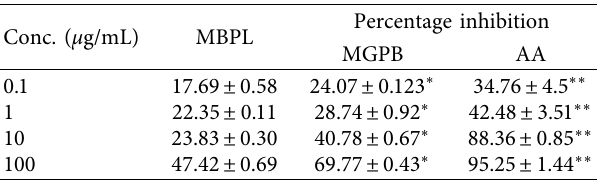
Figure 1: Calibration curve of gallic acid standard for total phenolic content. Concentrations of the gallic acids were prepared in µ g/mL. Table 1: Antioxidant activity of leaves of G. pinnata and barks of B. pinnatum . MGPB has significant antioxidant activity compared to MBPL in a dose-dependent